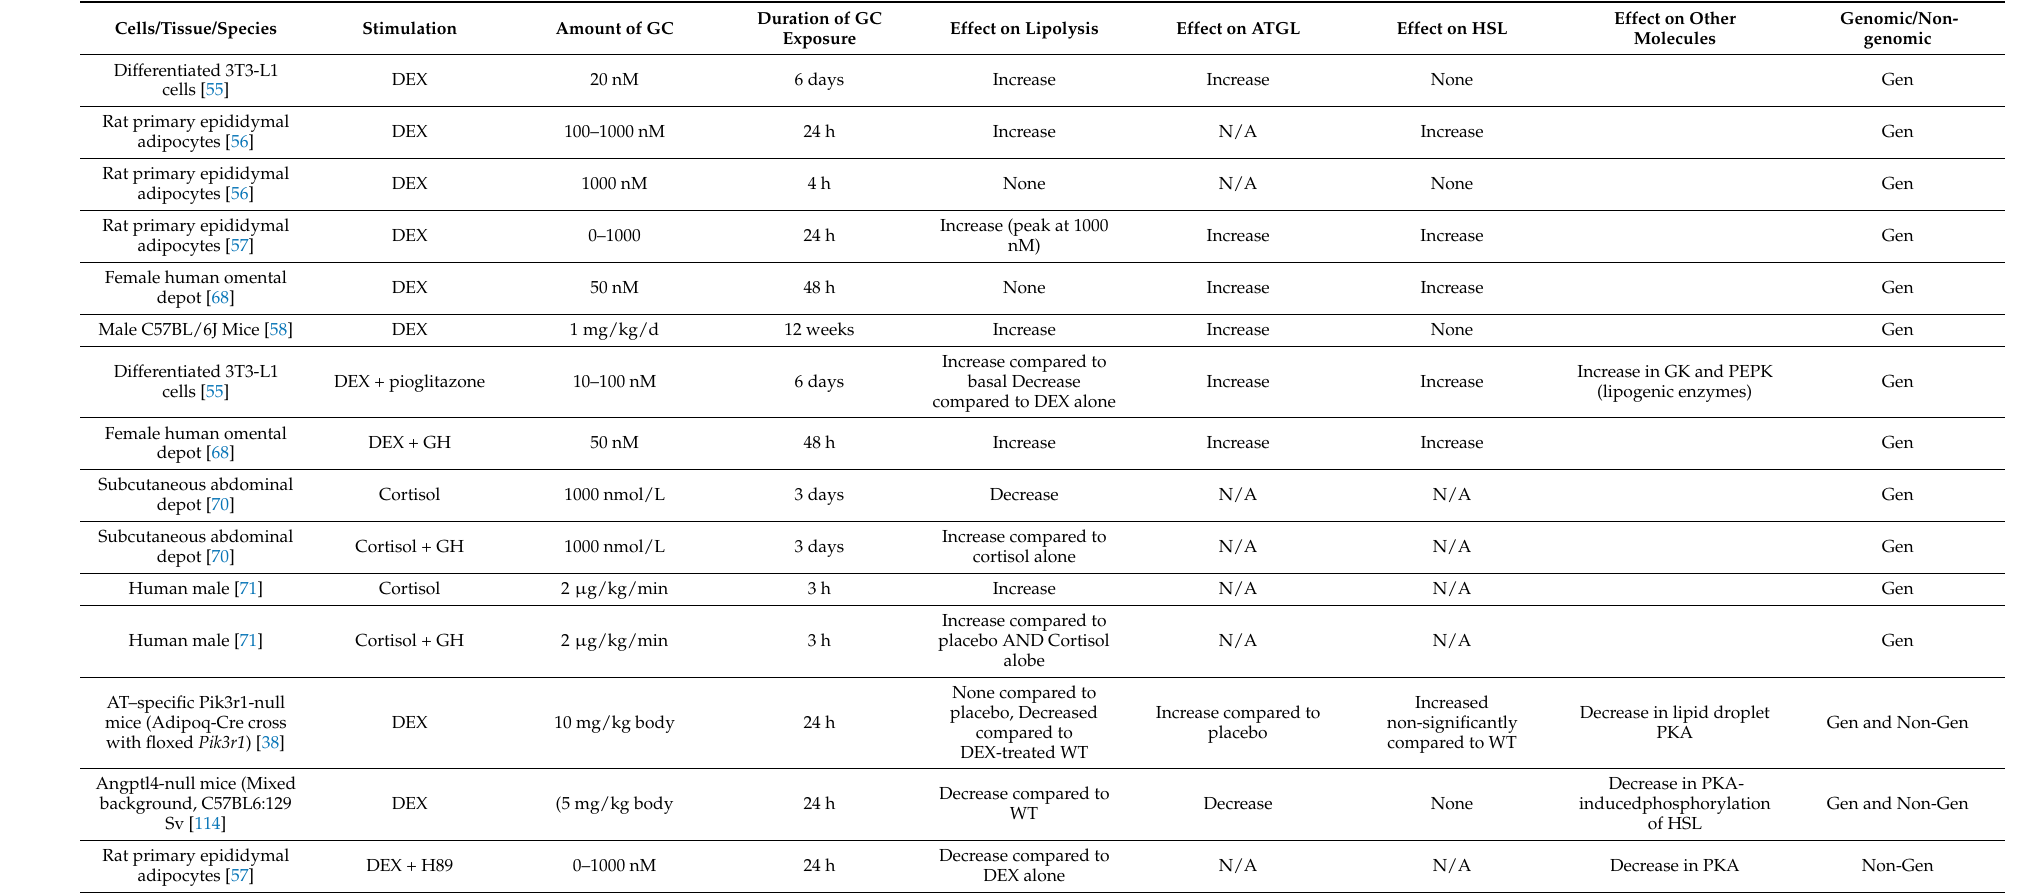
Table 3. Summary of gain of GC function studies on lipolysis in